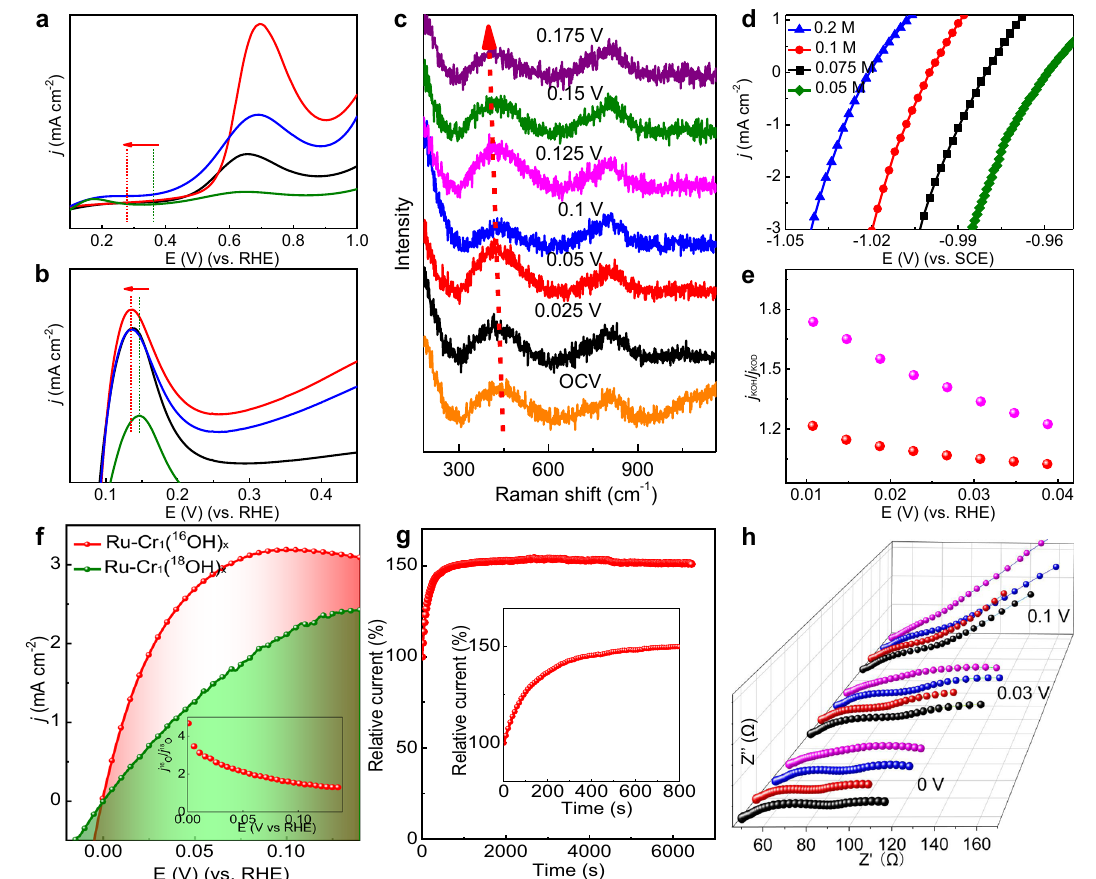
Fig.6|Mechanisminvestigation. CO-stripping( a )andH upd ( b )measurementsfor Ru – Cr 1 (OH) x − 0.6 (black), Ru – Cr 1 (OH) x − 1.1 (red), Ru – Cr 1 (OH) x − 2.2 (blue), and Ru NPs(green). c InsituRamanspectraofRu – Cr 1 (OH) x − 1.1atdifferentoverpotentials. d LSV curves of Ru – Cr 1 (OH) x − 1.1 for HOR in different pHconditions. e H/D isotope effect analysis ( j KOH / j KOD vs. potential) for Ru – Cr 1 (OH) x − 1.1 (red) and Pt/C (pink)